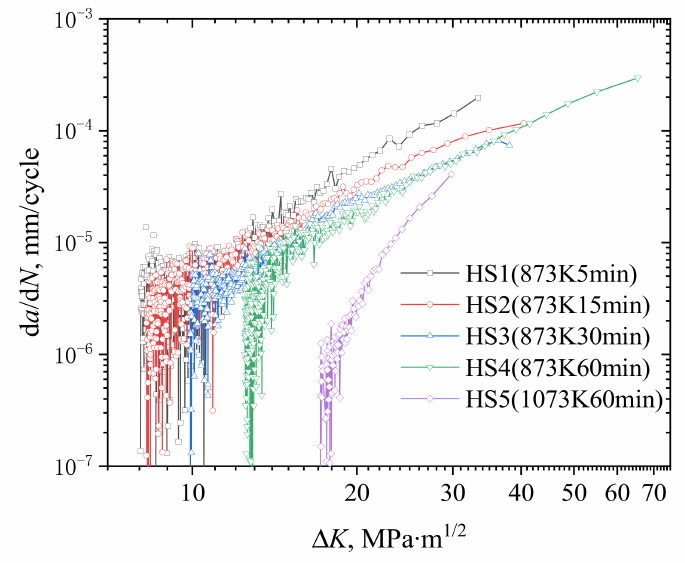
Figure 4. d a /d N - ∆ K curves of the specimens with different heterogeneous